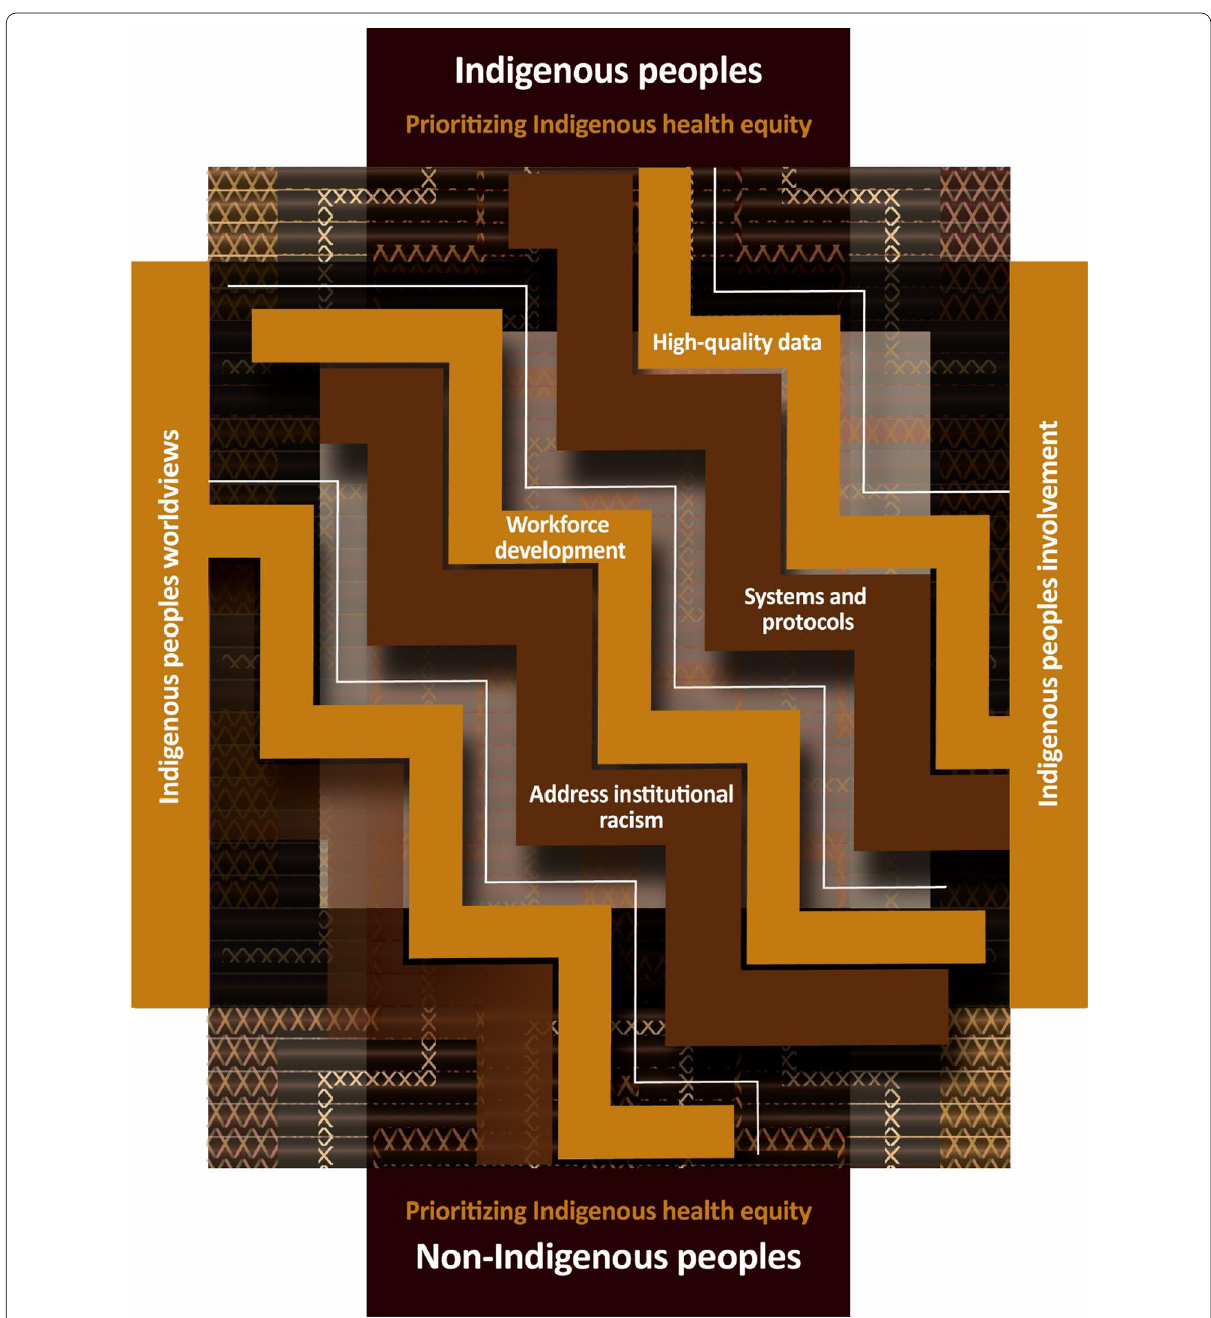
Fig. 1 A preliminary framework for embedding Indigenous health equity in health